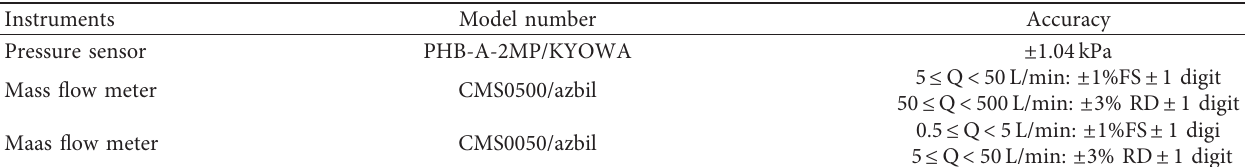
Figure 4: Experimental apparatus. Table 2: Instruments and